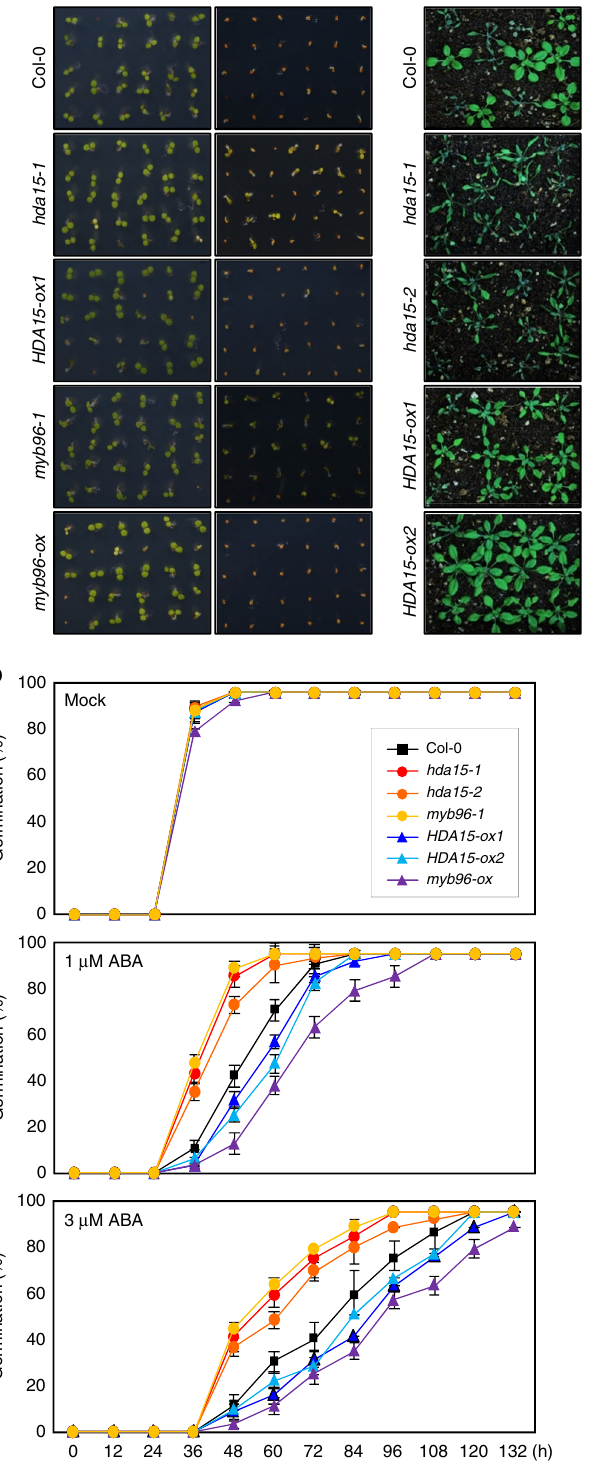
(Fig. 3a), suggesting that they work together especially at high concentrations of